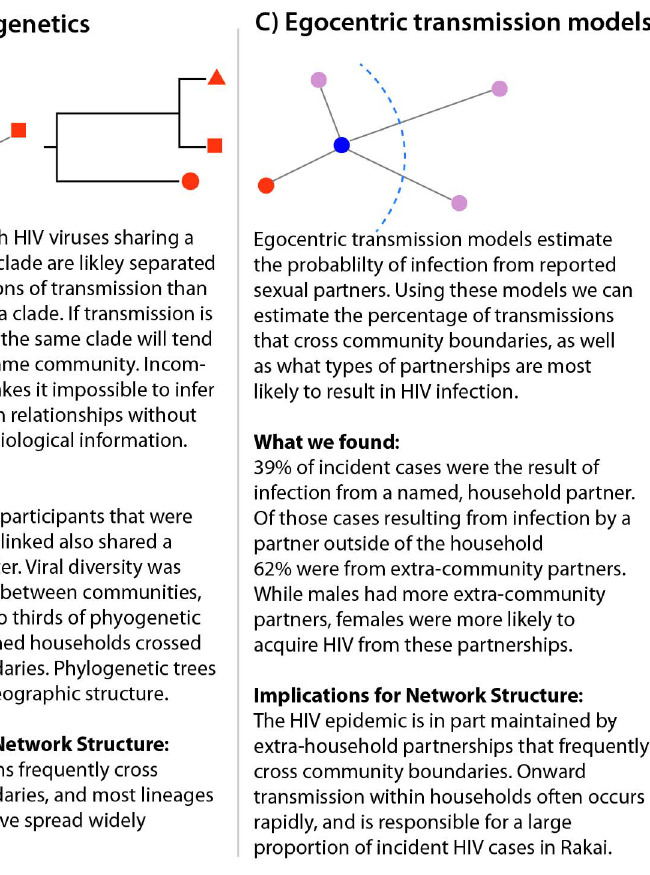
Figure 4. Summary of inferential methods and study results and conclusions. The dotted blue line represents the border of a hypothetical community.